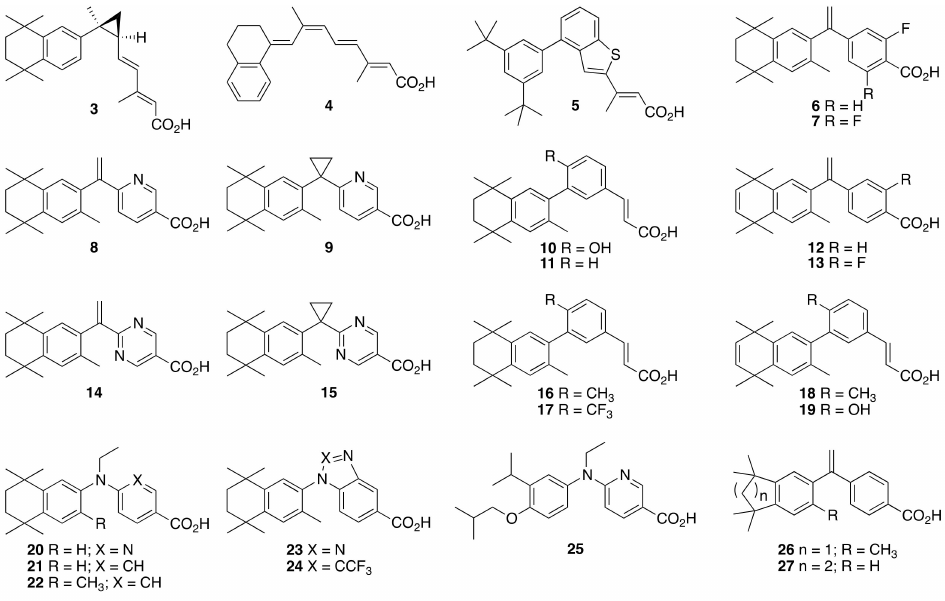
Figure 2. Structures of reported rexinoids 3 – 27 .